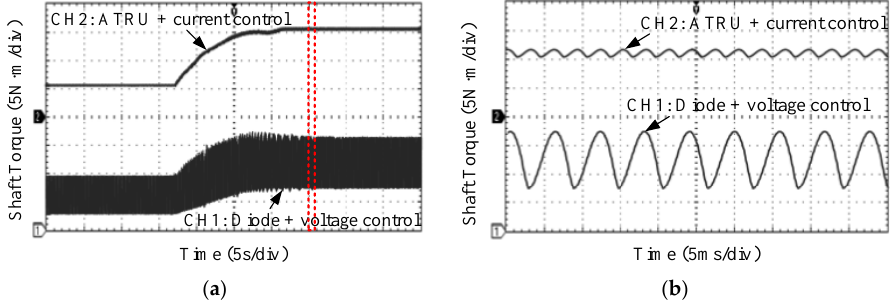
Figure 10. Detected shaft torque with and without proposed method. ( a ) waveforms; ( b ) zoomed in torque waveforms inside the dotted area of Figure 10a.